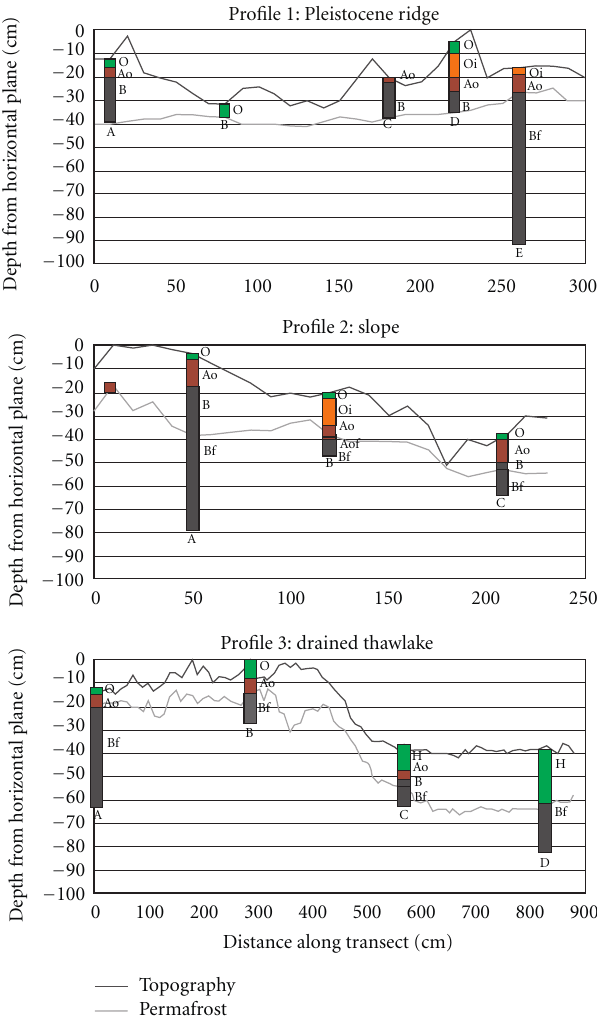
Figure 2: Soil profile descriptions along three transects (green = organic material, orange slightly decomposed organic = soil, brown = decomposed organic soil, and grey = mineral soil). Names of occurring plant species are given in the Appendix, including the estimated fractional